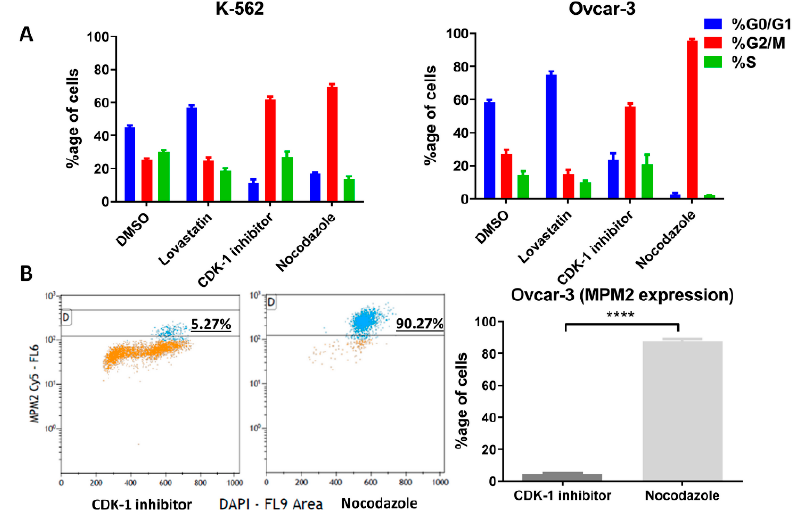
Figure 3. Cell phase following cell cycle inhibition. The two cell lines were synchronized in G1 phase using lovastatin, G2 phase using CDK-1 inhibitor and mitosis phase using nocodazole. ( A ). Percentage of each cells in different cell cycle phases (K-562, right and OVCAR-3 left) analyzed through FACS (Michael H. Fox algorithm) using DAPI is presented. ( B ). Percentage of positive cells with MPM2 staining show mitotic cells (OVCAR-3) following CDK-1 inhibitor and nocodazole treatment. Nocodazole blocks cells in mitotic phase while low expression of MPM2 in CDK-1 inhibitor-treated cells shows that it blocks cells only in G2 phase (****, p < 0.0001 unpaired t -test).